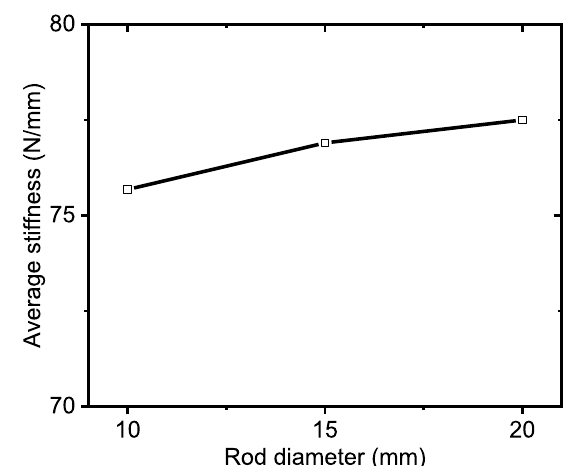
Figure 13 Change of identified stiffness with rod diameter